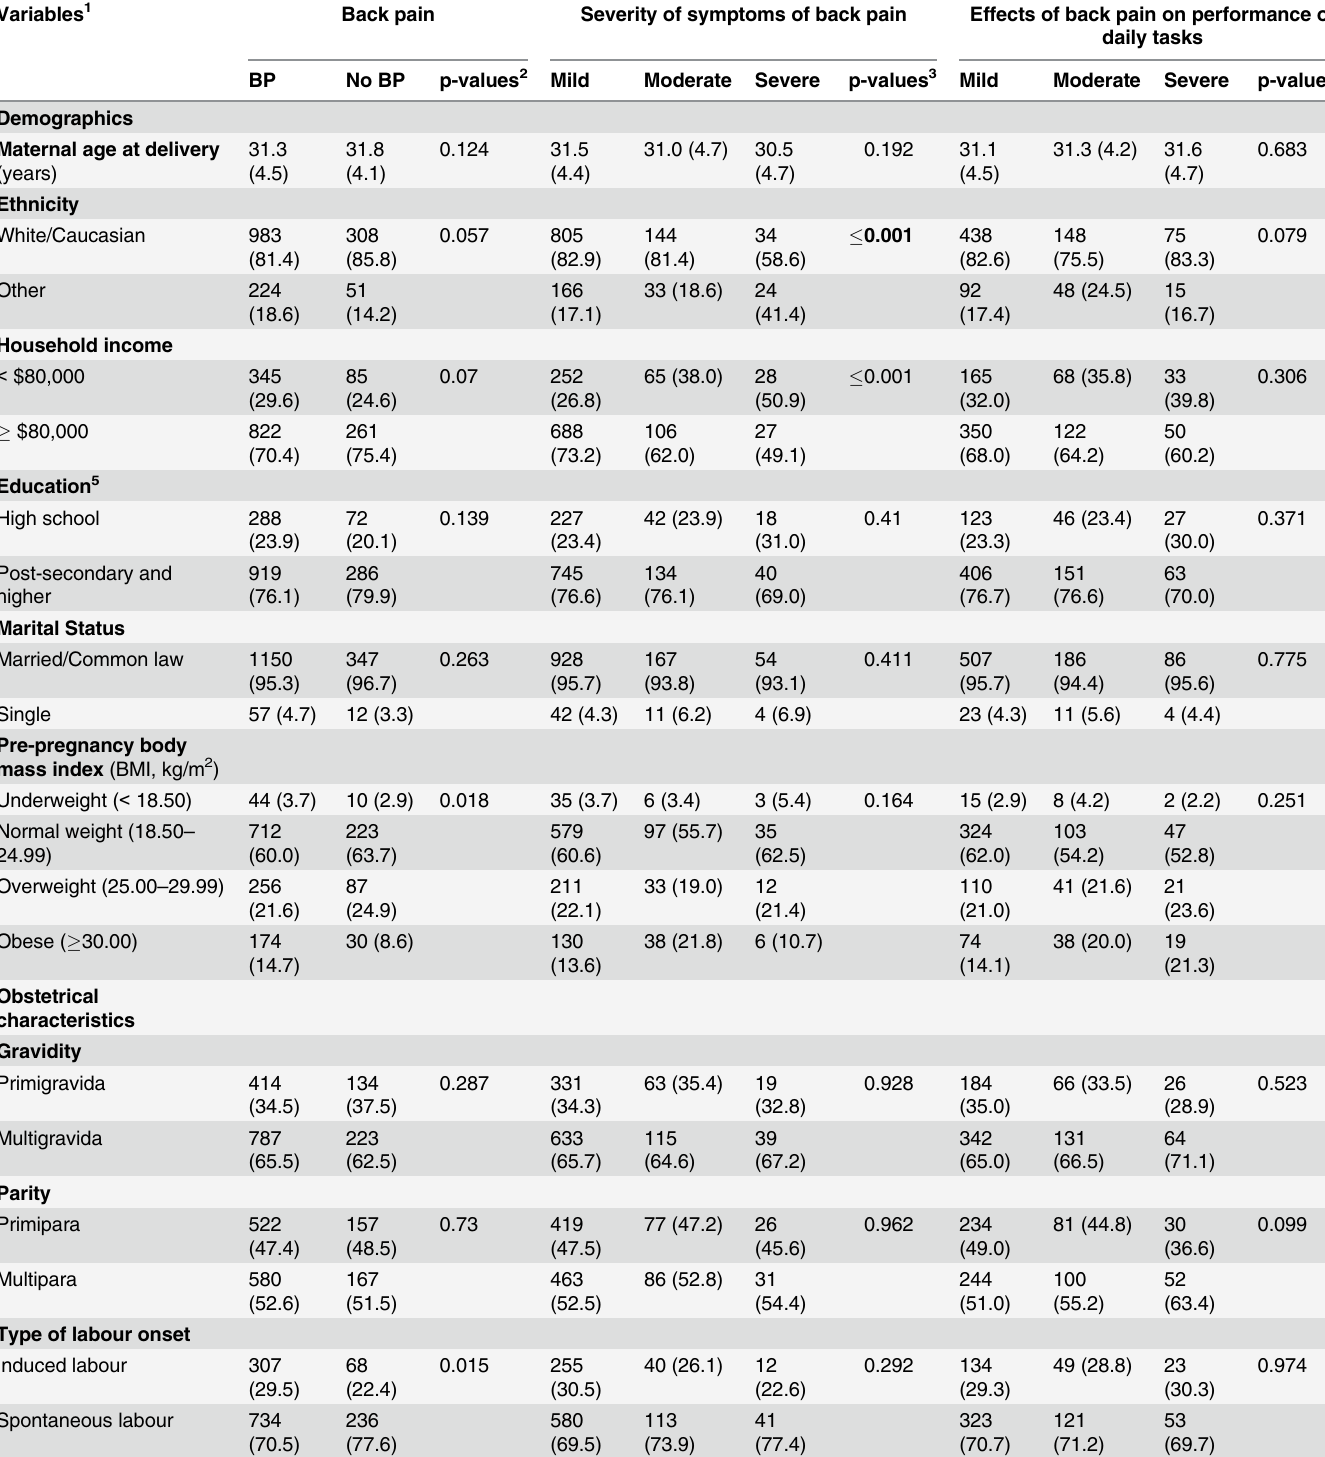
Table 2. Severity of symptoms and effect on maternal performance of daily tasks due to back pain at 12 months postpartum. Variables 1